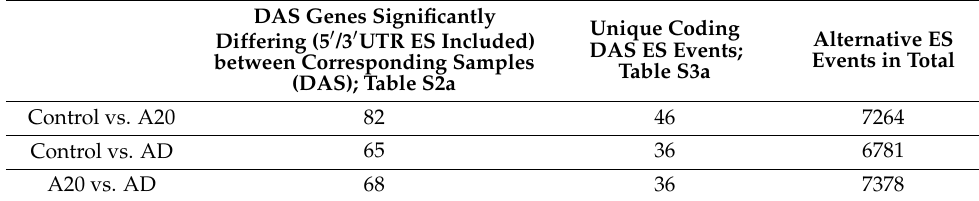
Table 1. Distribution of the statistically significant (FDR < 0.11) differential exon splicing events across three comparisons by rMATs.